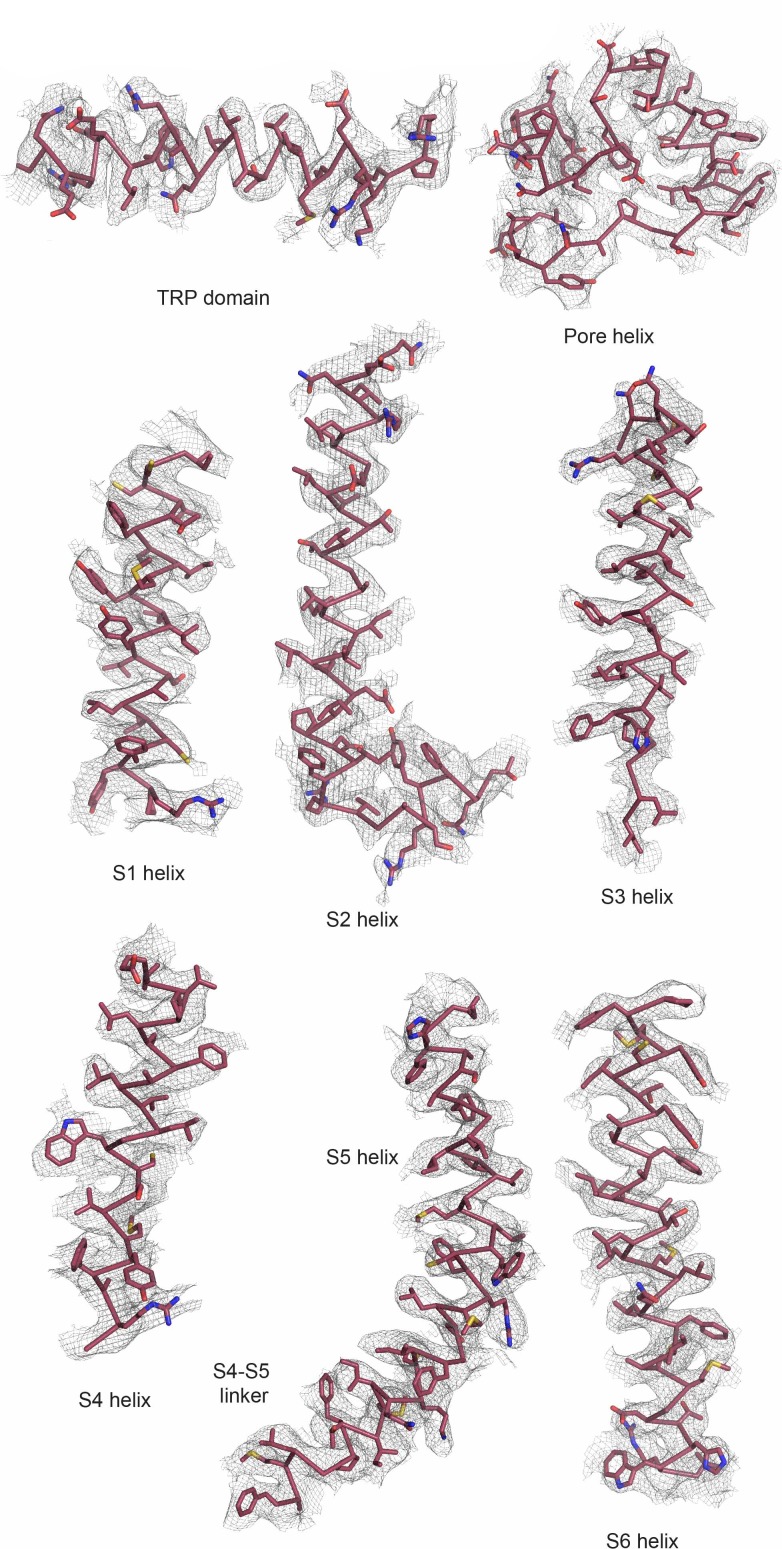
Data quality of ZINC17988990-bound TRPV5 in nanodiscs.Various helices of ZINC17988990-bound TRPV5 shown as atomic models (red ribbons) with the corresponding cryo-EM density (gray mesh).